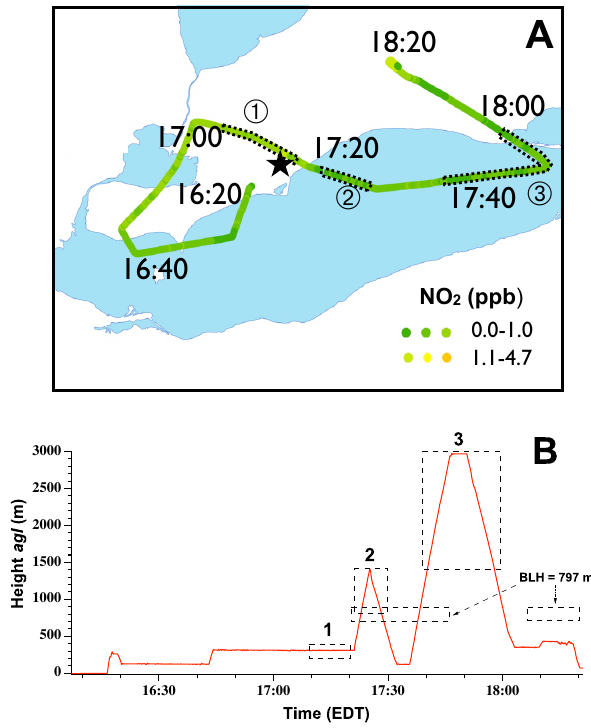
Fig. 7. Flight path on 26 June 2007. Panel (A) shows the NO 2 mixing ratios and the aircraft location every 20 minutes. Panel (B) shows the aircraft elevation and BLH (a.g.l.) as a function of time. The numbered sections show the locations, elevations, and approx- imate mixing ratios used for constructing the composite NO 2 pro- files. The Ridgetown supersite location is starred.